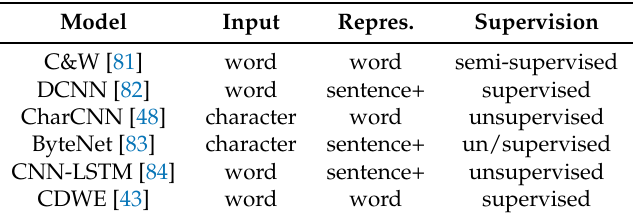
Table 4. The categorization of convolutional models by input level, representation level, and supervision. Un/supervised supervision represents both unsupervised and supervised